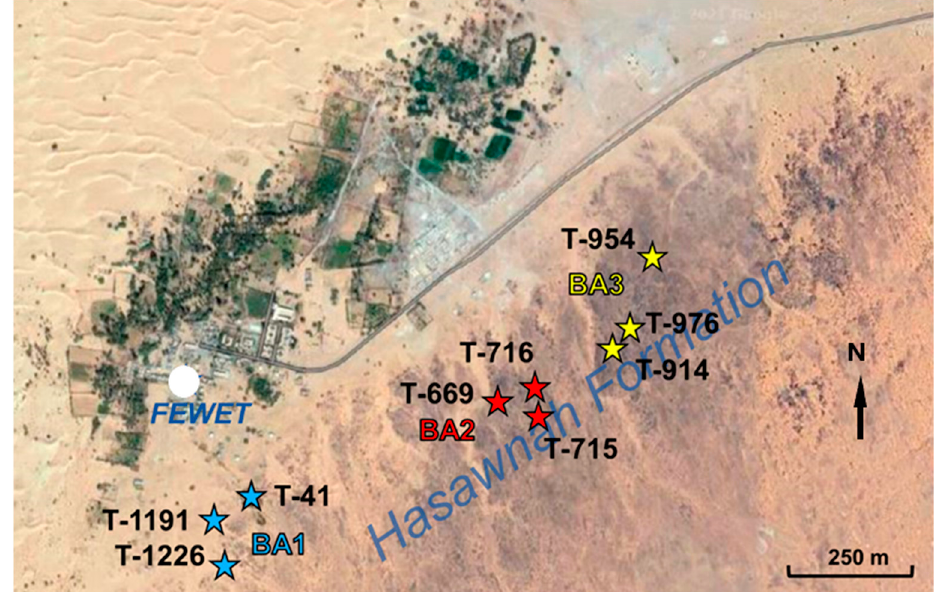
Figure 1. Satellite image of the Fewet oasis area in the Sahara of SW Libya (modified from Google maps), showing the three burial areas of the necropolis and the tumuli from which human bone samples were collected. Light blue stars: tumuli in BA1; red stars: tumuli in BA2; yellow stars: tumuli in BA3; white circle: Fewet village’s main settlement.